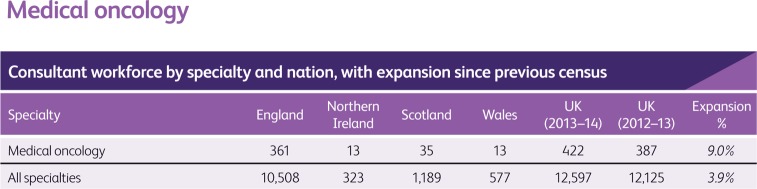
Data provided by the Royal College of Physicians shows the distribution of medical oncologists between the countries of the United Kingdom and the continued expansion between 2012/13 and 2013/14. The rate of expansion is faster than that across all medical specialties. Reproduced with permission. (Federation of the Royal Colleges of Physicians of the UK. Census of consultant physicians and higher specialty trainees in the UK: specialty reports, 2013–14. London: Royal College of Physicians, 2015: 155 and 157.)